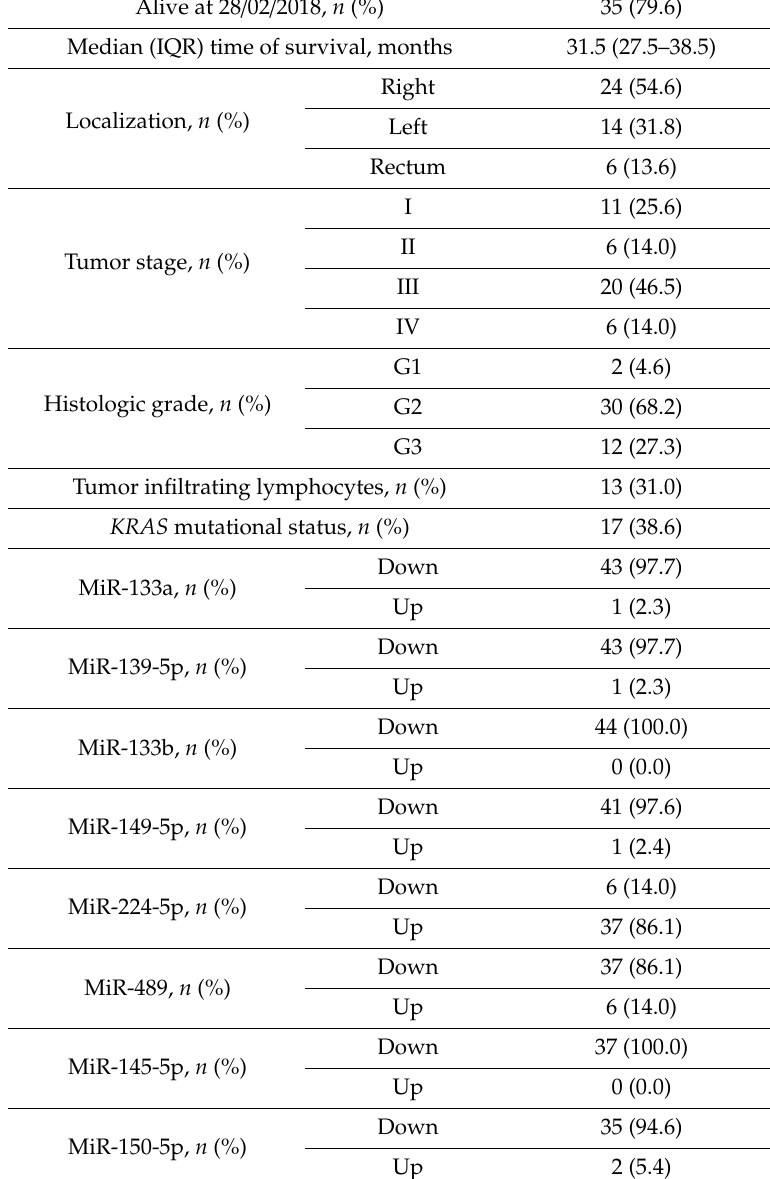
Table 2. Descriptive analysis of qualitative and quantitative